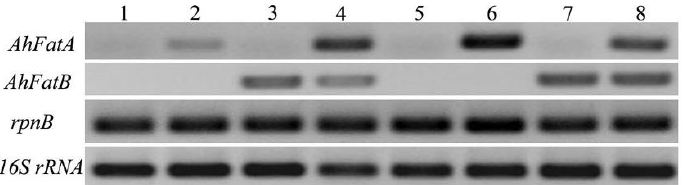
Figure 3. Semi-quantitative RT-PCR analysis of Acyl-ACP thioesterases from Arachis hypogaea L. in Synechocystis transformants. Lane 1: wild type Syenchocystis sp. PCC6803; Lane 2: pSD FatA Synechocystis transformant; Lane 3: pSD FatB Synechocystis transformant; Lane 4: pSD FatAB Synechocystis transformant; Lane 5: WT Syenchocystis sp. PCC6803; Lane 6: pSD FatA Synechocystis transformant; Lane 7: pSD FatB Synechocystis transformant; Lane 8: pSD FatAB Synechocystis transformant. All